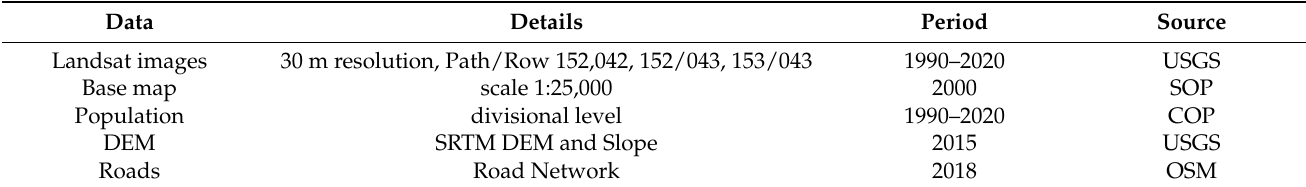
Table 1. Details of datasets used in this